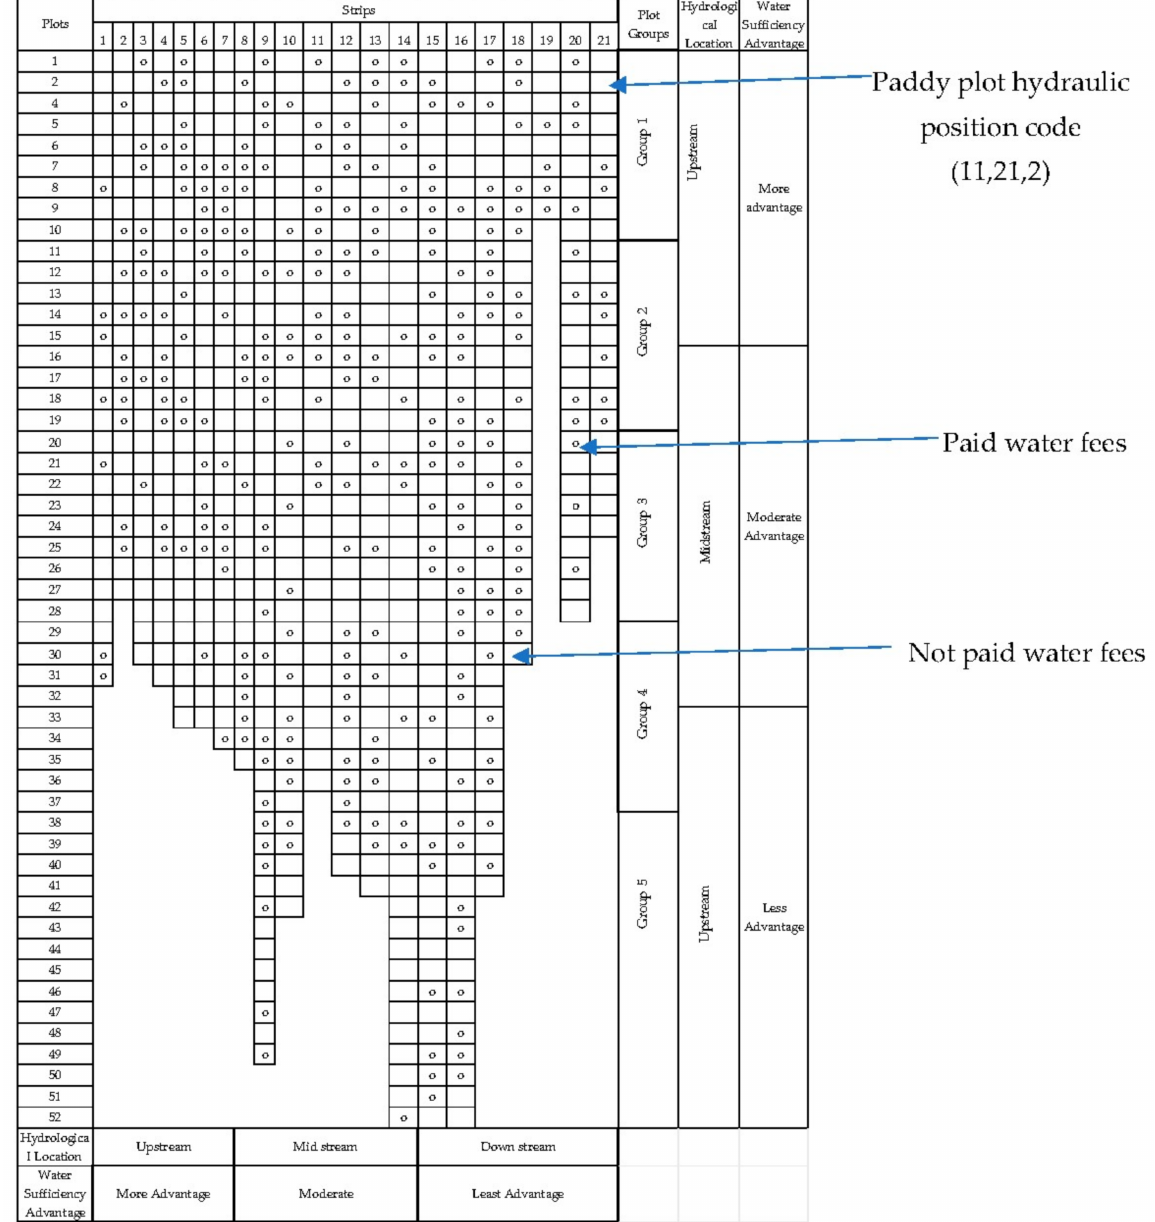
Figure 4. Database of farmers’ fee compliance and hydraulic position of plots in the